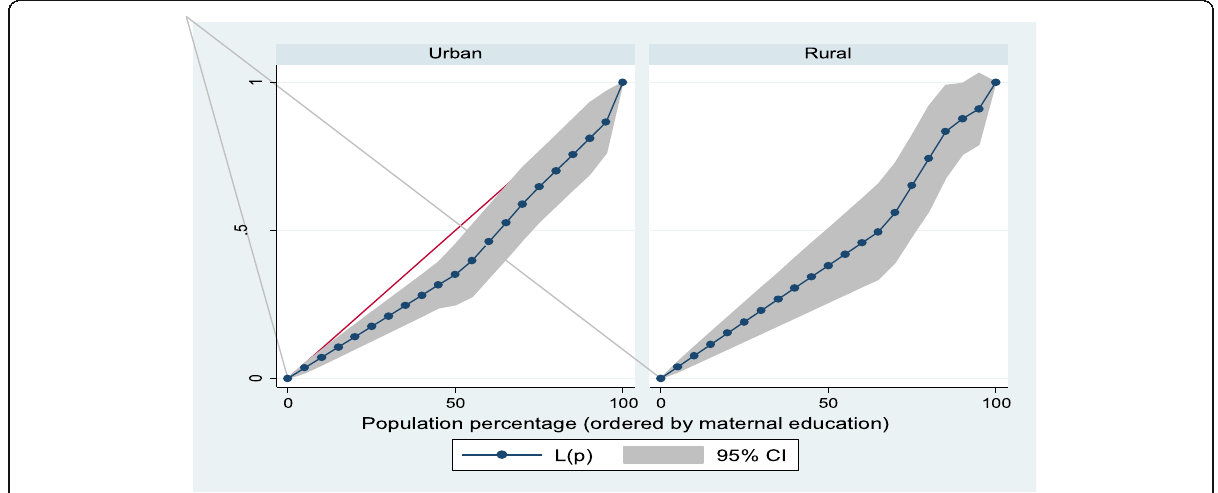
Fig. 2 Urban-rural differential in maternal education inequalities of ≥ 8 ANC